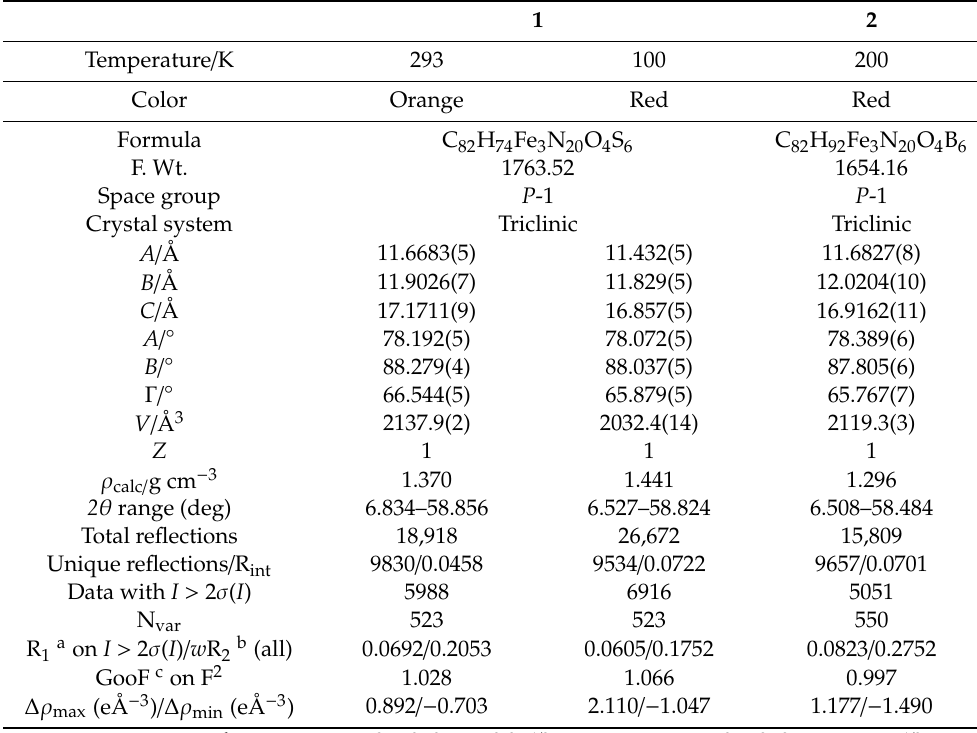
Table 1. Crystal data and structure